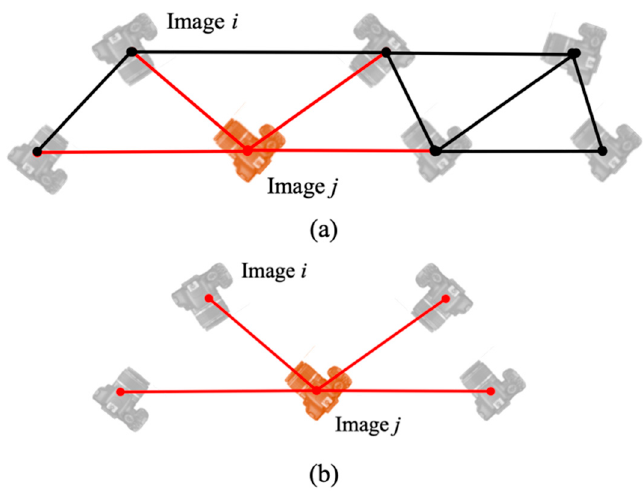
Figure 8. ( a ) The graph structure for a block of overlapping images, and ( b ) the established sub-graph at image 𝑗.